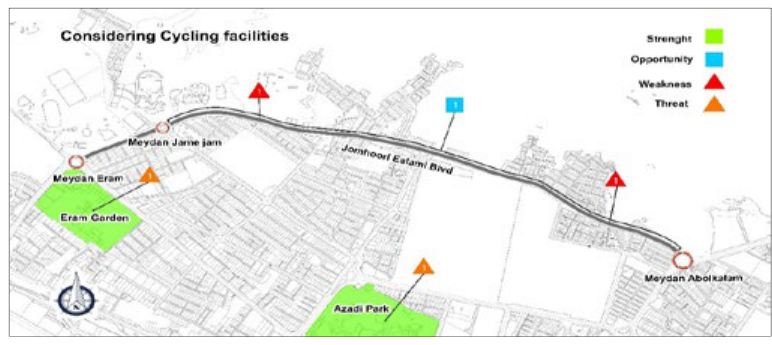
Fig. 5: Improving public transportation Fig 4. Considering Cycling facilities